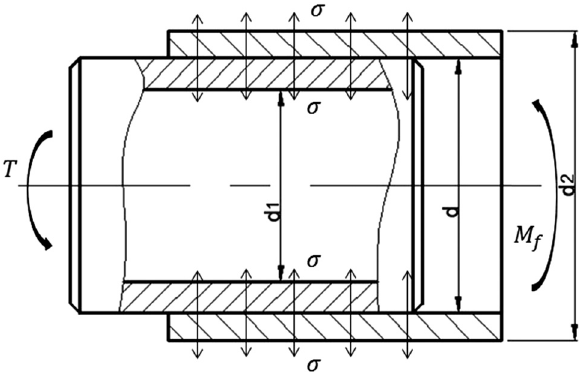
Figure 2: Geometry of the interference fi t